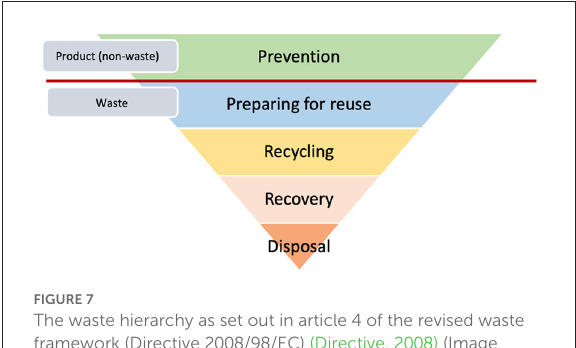
FIGURE7 The waste hierarchy as set out in article 4 of the revised waste framework (Directive 2008/98/EC) (Directive, 2008) (Image taken from Allison et al.,